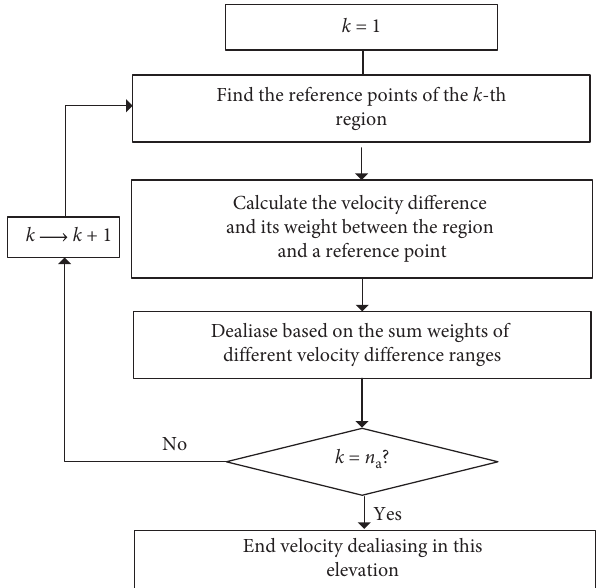
Figure 5: The flow chart of velocity dealiasing between interregions in each elevation